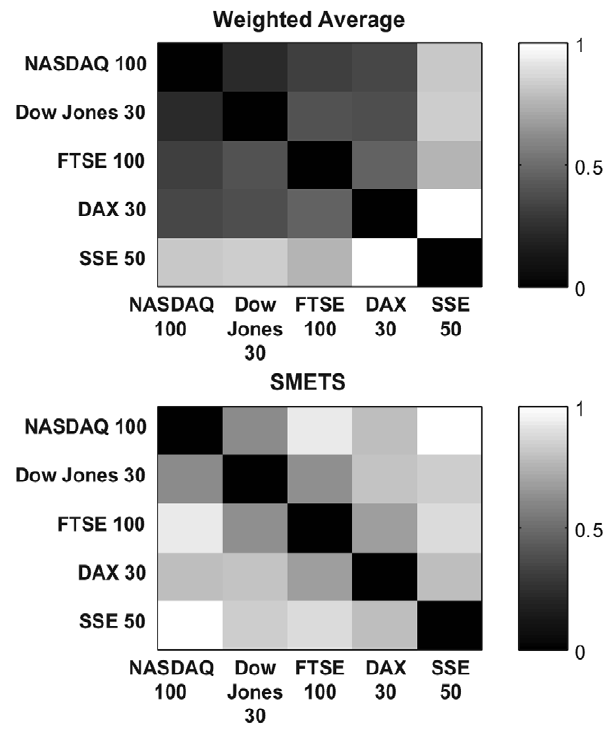
Figure 4. Distance matrices for the five stock indices. Distance values were measured using the weighted average and SMETS and are encoded in grayscale.